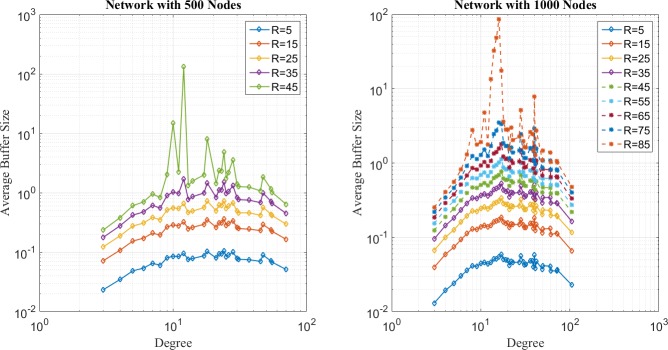
Relationship between average buffer size and node degree for EP on networks with 500 nodes (left figure) and 1000 nodes (right figure).